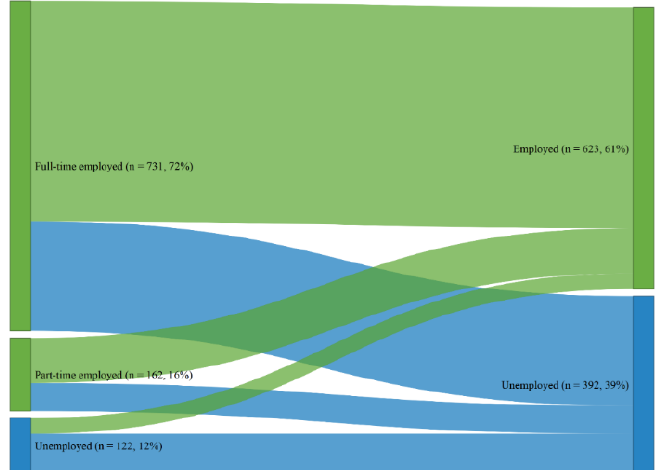
Figure 2. Employment status changes from baseline (left part) to one-year post TBI (right part). Note that the categorization of employment status at the two timepoints are different. At baseline employed: individuals were in labor market or currently at sick leave split in full-time and part-time groups; and unemployed: individuals were out of labor market. At one-year post TBI, employed individuals returned to work (either with the same amount of hours or with reduced hours, or individuals who changed the work); and unemployed individuals, who are unable to work and individuals looking for